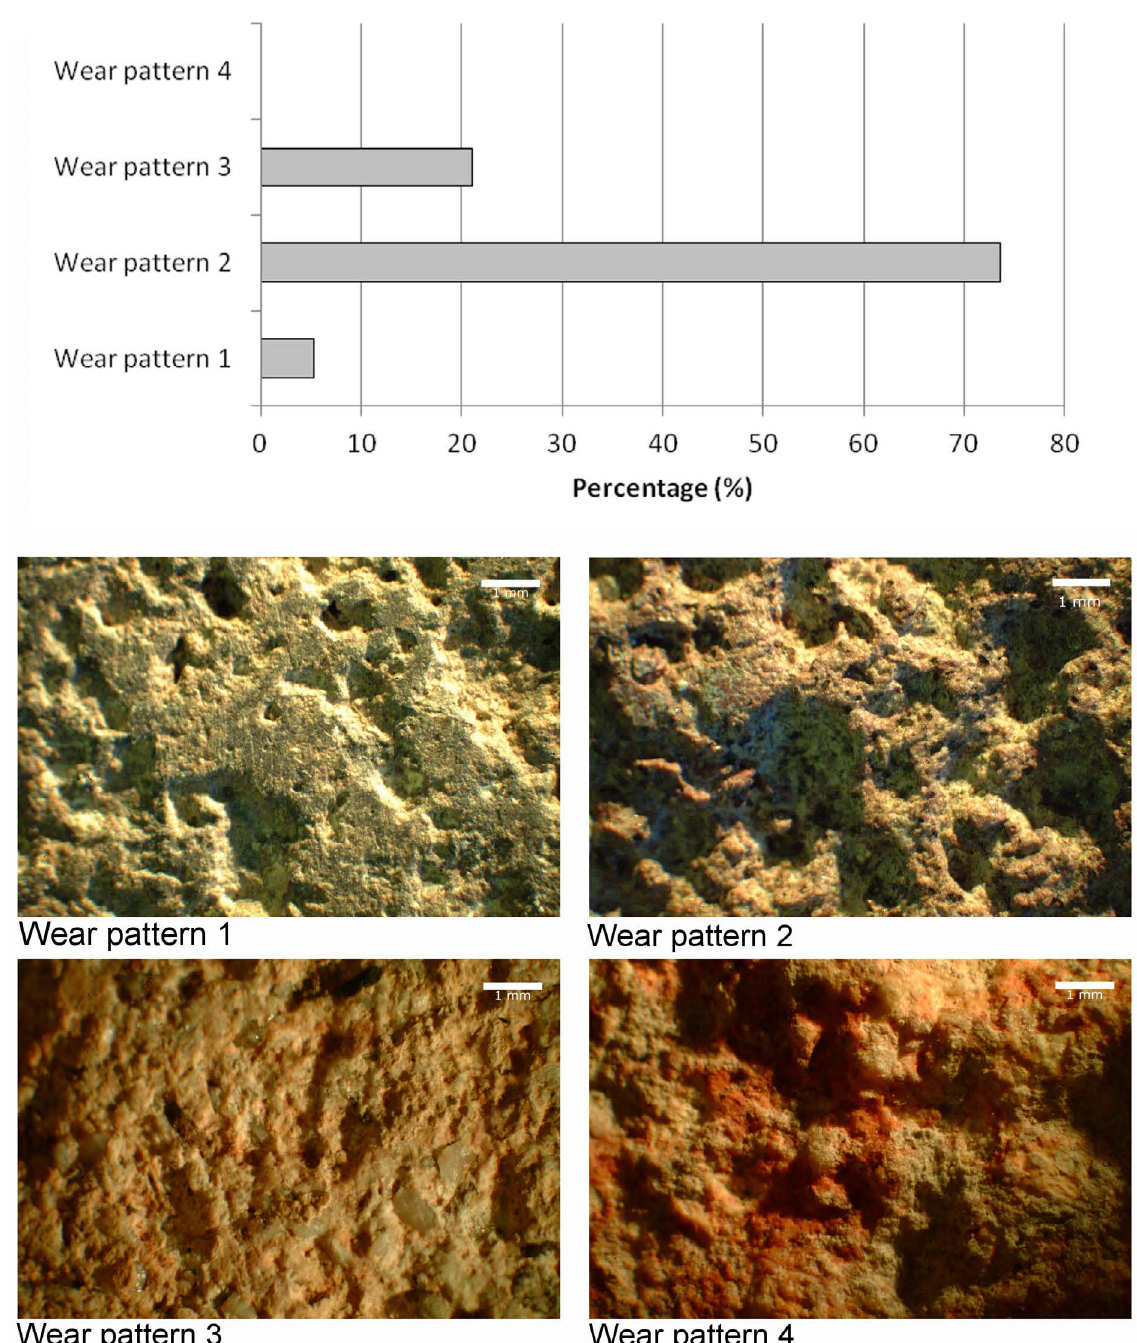
Figure 6. Frequencies of wear patterns observed on grinding slabs from Argaric settlements of the Guadalentín valley (source for graphic, Delgado-Raack 2008: fig. 4.1.35; source for pictures Delgado-Raack 2008: 330-337). Wear pattern 1: grinding with stone rubber; 2: grinding with wooden rubber; 3: multifunctional use (friction, pounding, cutting); 4: mineral